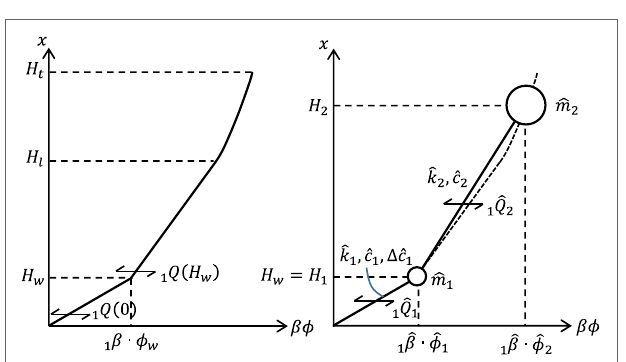
FIGURE 12 | Correspondence of participation vectors and story shear forces between shear-beam model and 2DOF